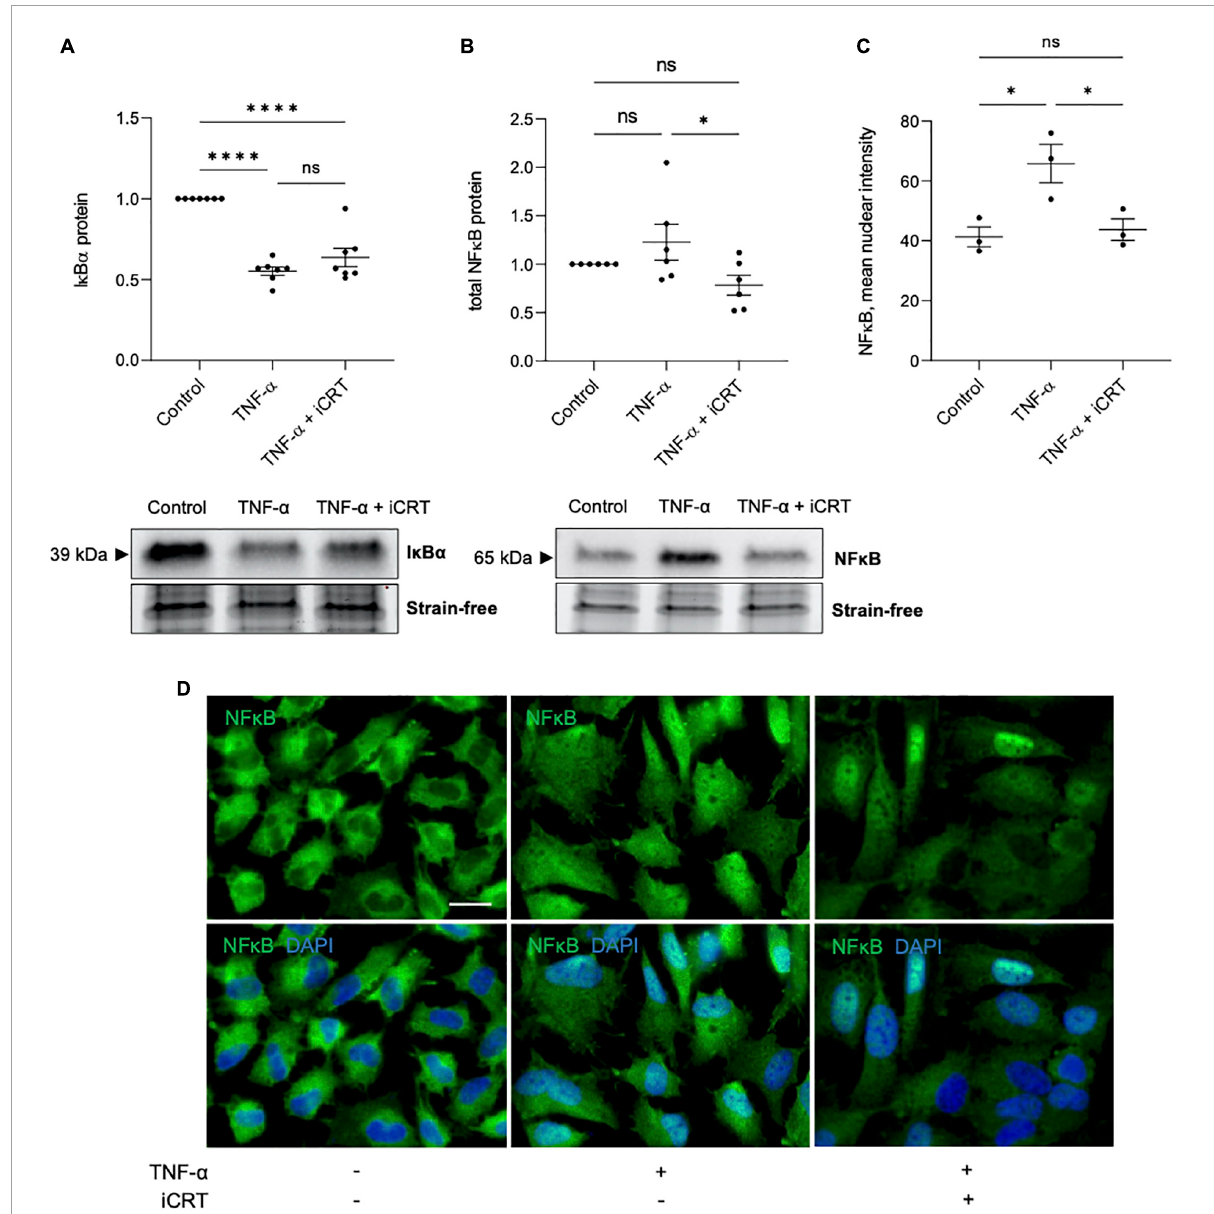
FIGURE2 Inhibition of Wnt/ β -catenin signaling disrupted the inflammatory TNF- α -NF κ B signaling axis. HUVECs were stimulated with 10ng/mL recombinant human TNF- α in the presence of either 0.05% DMSO vehicle control or 25 µ M iCRT for 18 h. (A) I κ B α from whole cell lysates was quantified by Western blotting, normalized to stain-free loading controls and expressed as a fold change of control ( n = 7). Representative Western blot and stain-free loading control shown. (B) NF κ B from whole cell lysates was quantified by Western blotting, normalized to stain-free loading controls and expressed as a fold change of control ( n = 6). Representative Western blot and stain-free loading control shown. (C) Following immunofluorescence for NF κ B, mean nuclear NF κ B levels were quantified using a Fiji-based macro ( n = 3). (D) Representative images of HUVECs immunostained for NF κ B (green). Nuclei were stained with DAPI (blue). Scale bar represents 10 µ m and applies to all panels. * p < 0.05, ** p < 0.01, *** p < 0.001, and **** p < 0.0001. ns, not significant.